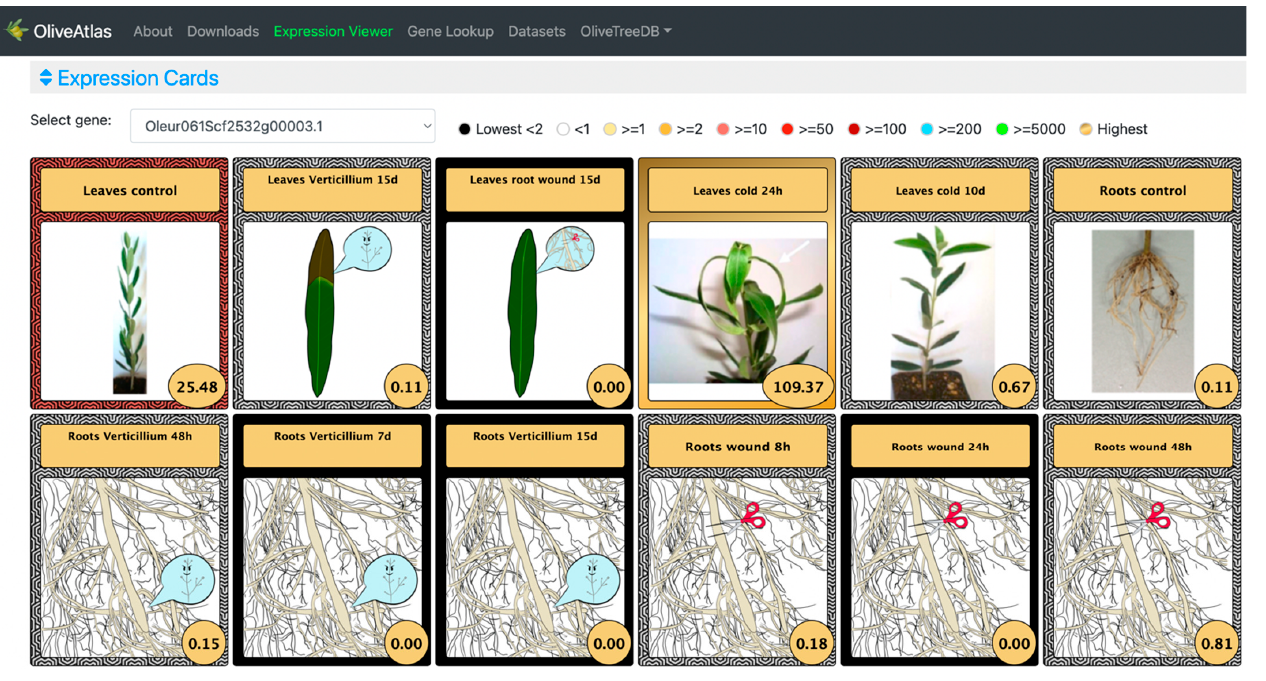
Figure 5. Expression cards in the “Expression viewer” of OliveAtlas. The cards show different colors for different expression value ranges defined in the legend. The highest and lowest values are highlighted in a golden or black card respectively. The sample Roots wound 7d , with expression value 0, was not included for better visualization.